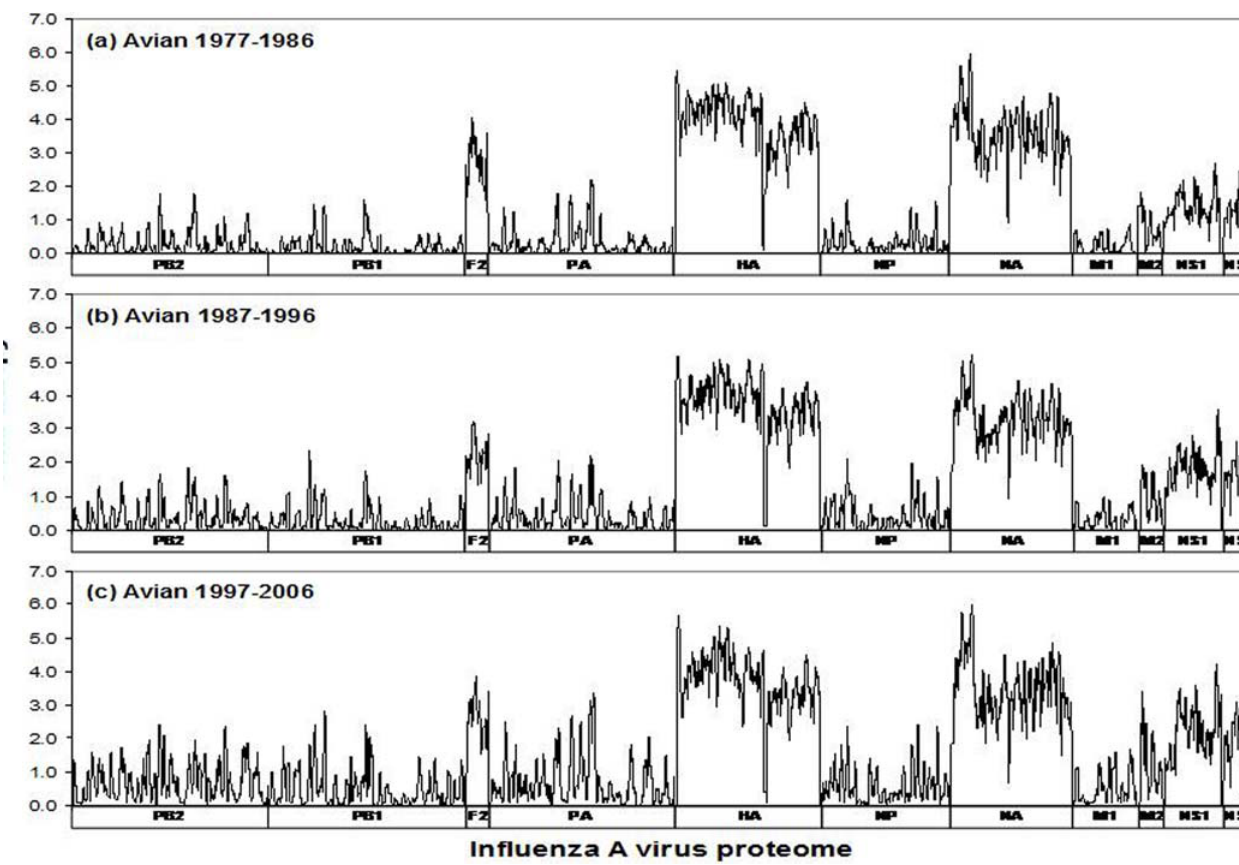
Figure 3. Entropy plots of the sequence alignments of recorded H5N1 viruses isolated from avian and human hosts (data as of September 30, 2006).